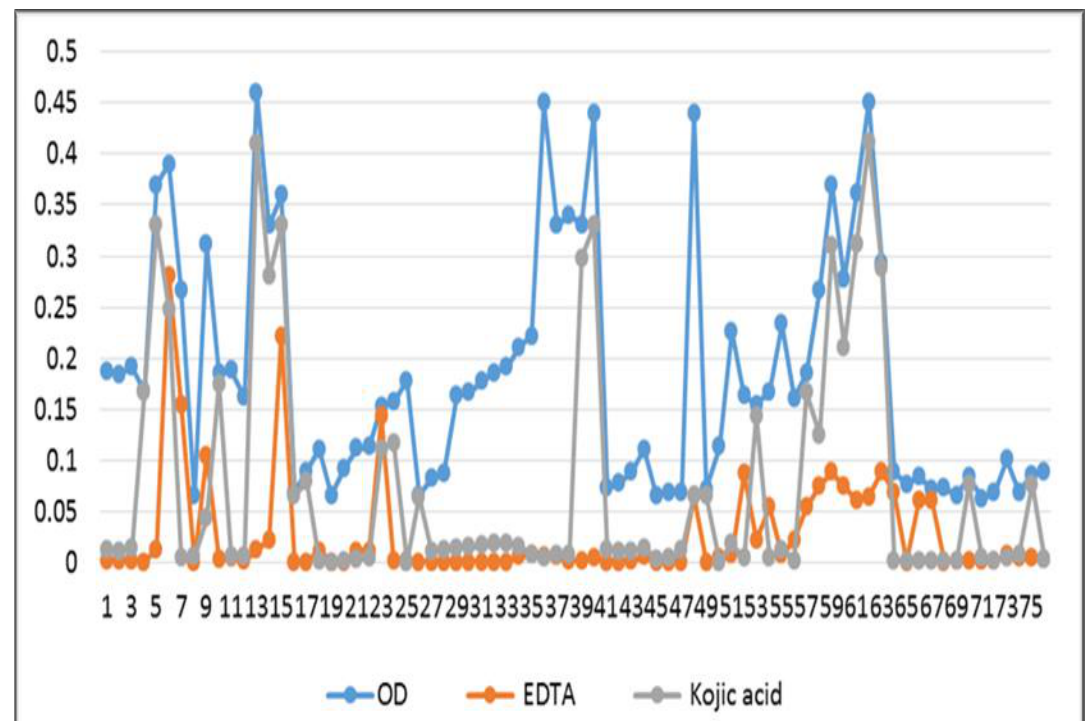
Figure 4. Optical density readings of biofilm-producers before and after exposure to EDTA and Kojic